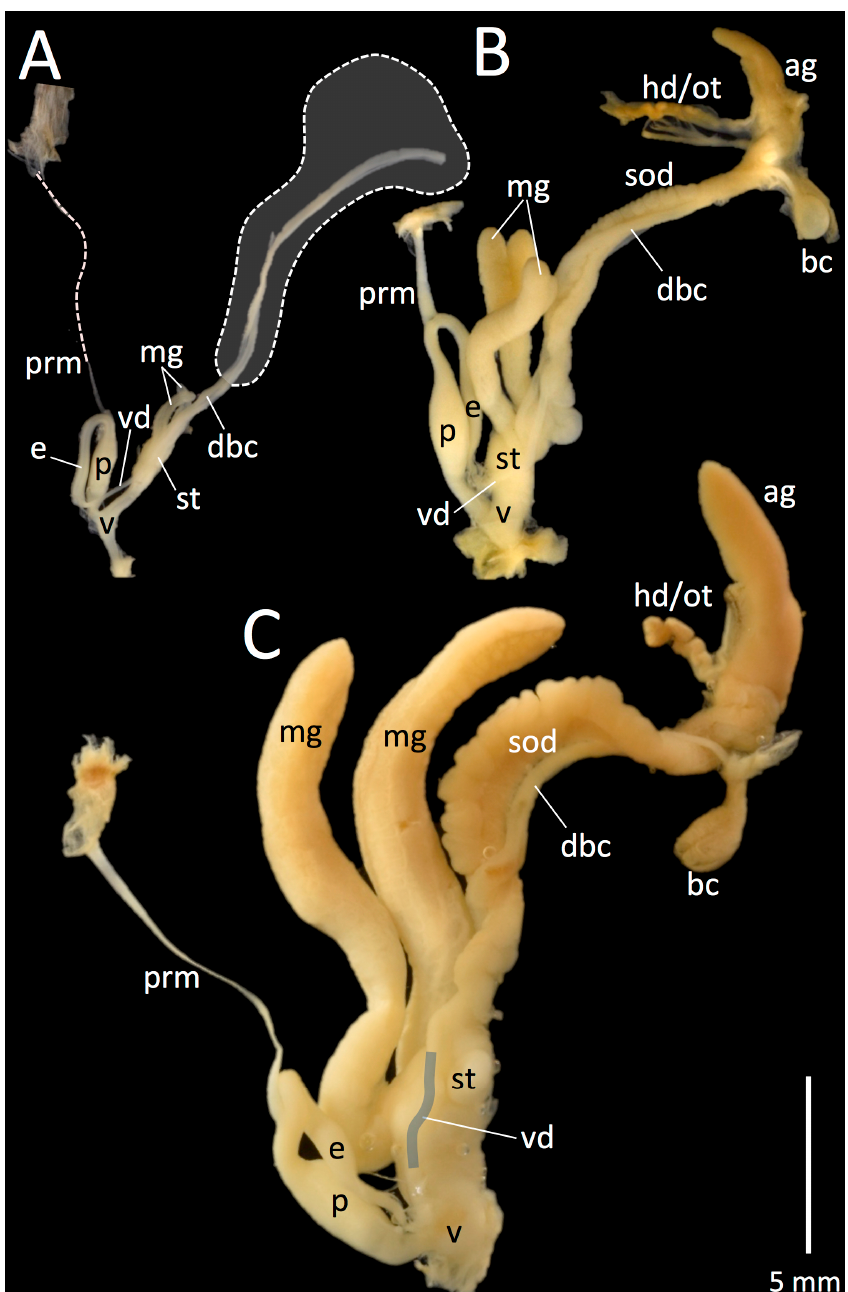
Figure 5. Theba pisana (Müller, 1774) reproductive systems at different stages of maturity from San Pedro, Los Angeles Co. ( A , C ) and San Elijo Lagoon Ecological Reserve, San Diego Co., California, USA ( B ). ( A ) LACM 182330 (immature), Marine Mammal Care Center, 22 June 2020; ( B ) LACM 182335 (immature?), Santa Carina trail, 12 September 2020; ( C ) LACM 182342 (mature), Grassland Loop Trail, White Point Nature Reserve, 17 October 2020. Abbreviations: ag: albumen gland; bc: bursa copulatrix; dbc: duct of bursa copulatrix; e: epiphallus; hd/ot: hermaphroditic duct/ovotestis; mg: mucous gland; p: phallus; prm: phallus retractor muscle; sod: spermoviduct; st: stylophore (dart sac); vd: vas deferens; v: vagina. In ( A ), the single dashed line indicates part of the phallus retractor muscle; the gray area within the dashed line indicates missing anatomy, including the sod, bc, ag, and hd/ot; in ( C ), the vas deferens is indicated in gray. Anatomical terminology is based on Koene and Schulenburg [43] and Holyoak and Holyoak [44]. Figure layout is based on Moran [42].